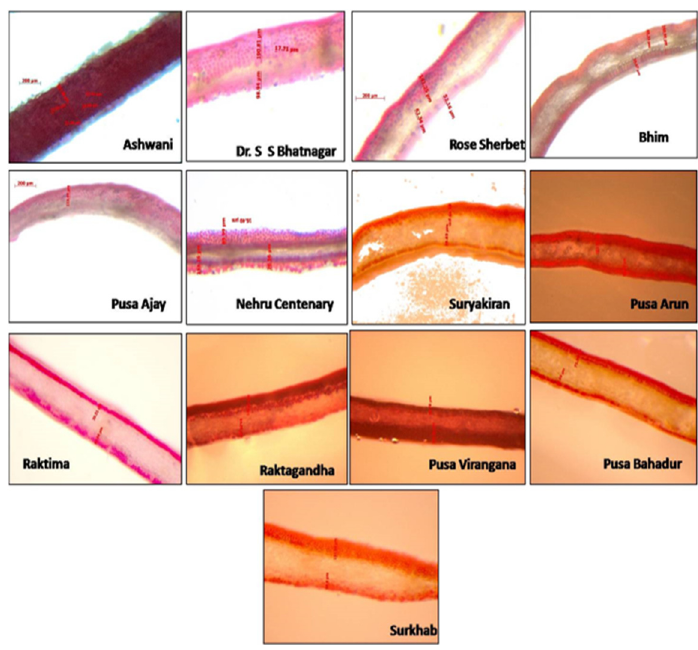
Figure 4. Histological examination of rose petals for anthocyanin distribution. Table 2. Variation in total phenolic content and antioxidant activities of rose